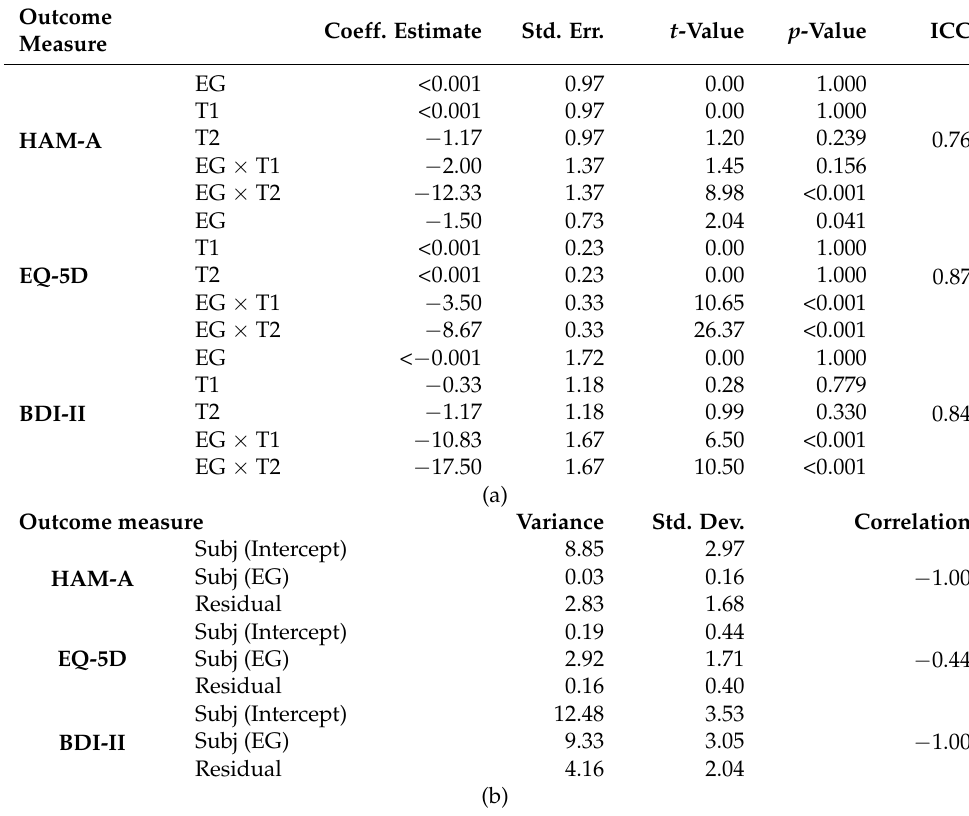
Table 3. Results of the mixed effects analysis performed on the outcome measures HAM-A, BDI-II, and EQ-5D: (a) Fixed effects; (b) Random